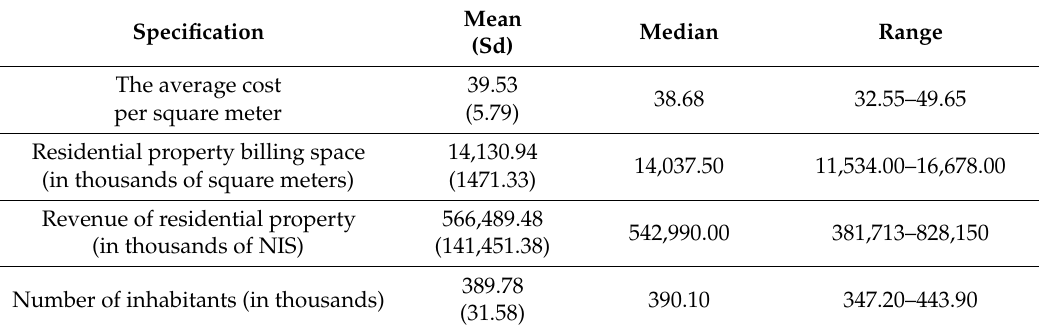
Table 1. Descriptive statistics of the variables for the city of Tel